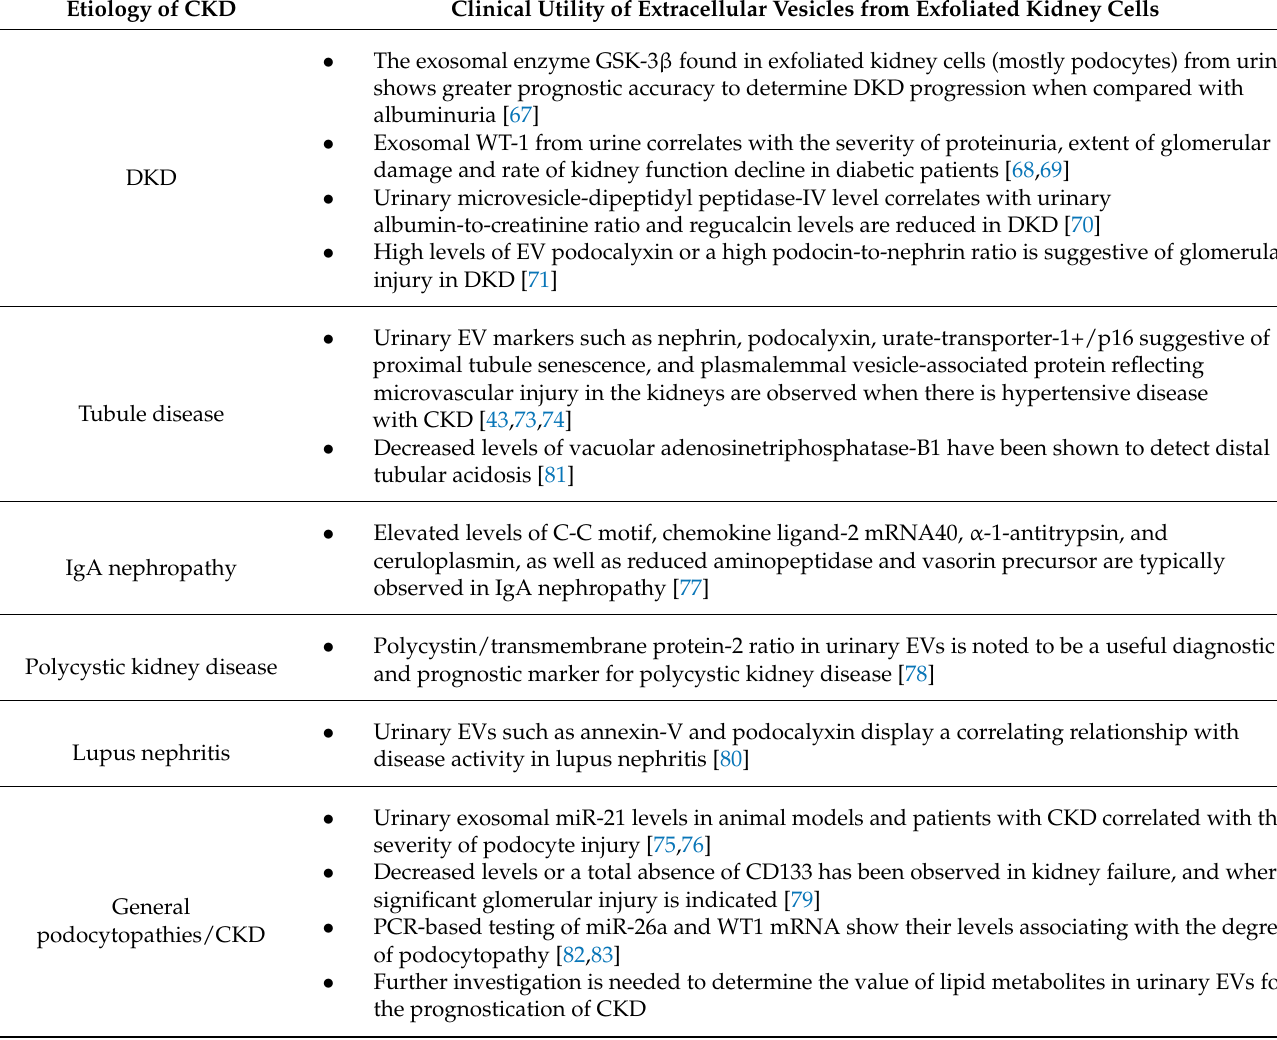
Table 2. Clinical utility of extracellular vesicles from exfoliated kidney cells for early diagnosis and prognostication of